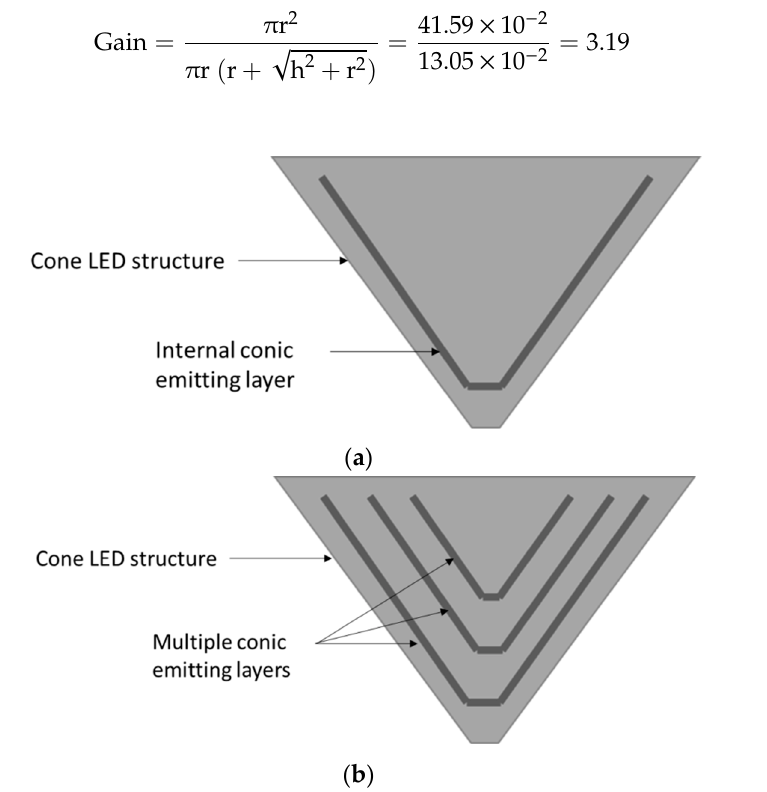
Figure 9. LED cone. ( a ) LED cone with internal conical emitting layer; ( b ) LED cone with multiple sub-cone emitting layers.